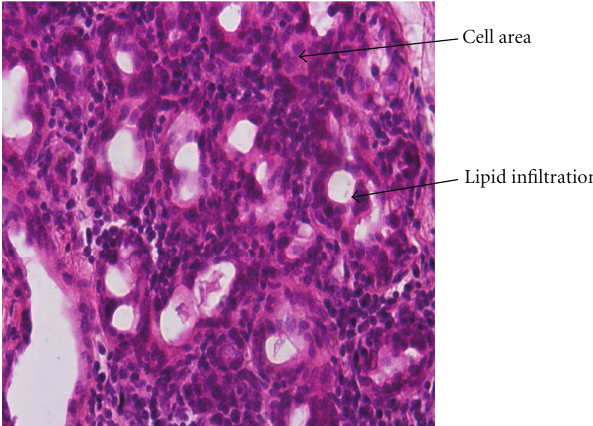
Figure 1: In group B1, lipid infiltration of the parotid parechyma, presence of lipocytes and nuclei abnormalities (increased cell area and duct’s diameter, decreased duct’s number) were observed (haematoxylin eosin— original magnification ×